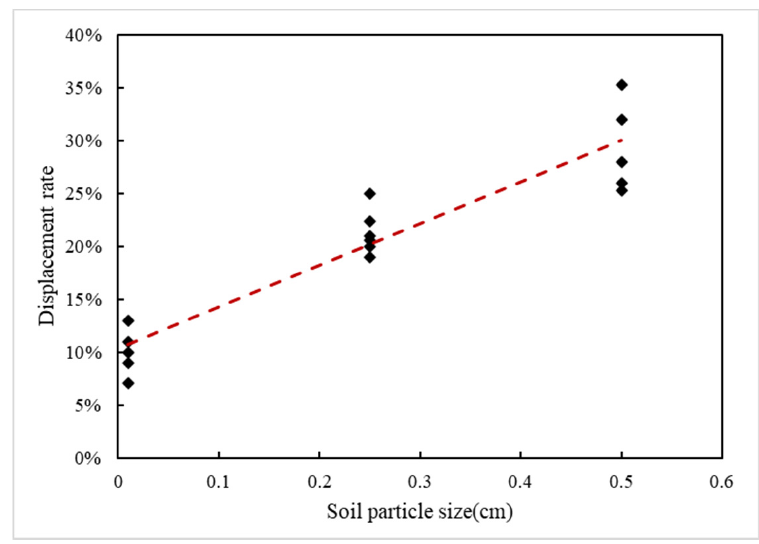
Figure 9. Relationship between the soil particle size and displacement rate.